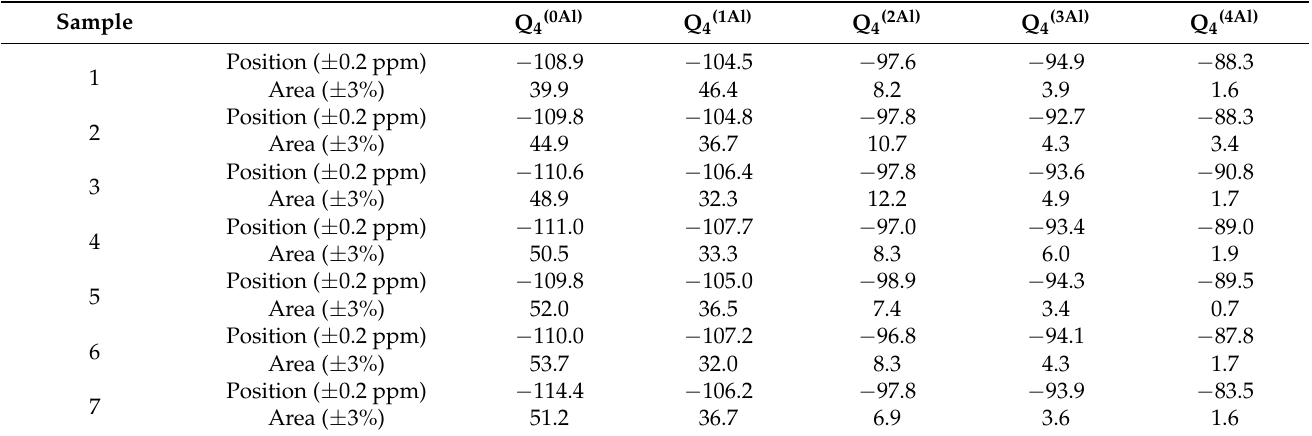
Table 4. Calculation results of Gaussian model fitting of 29 Si NMR